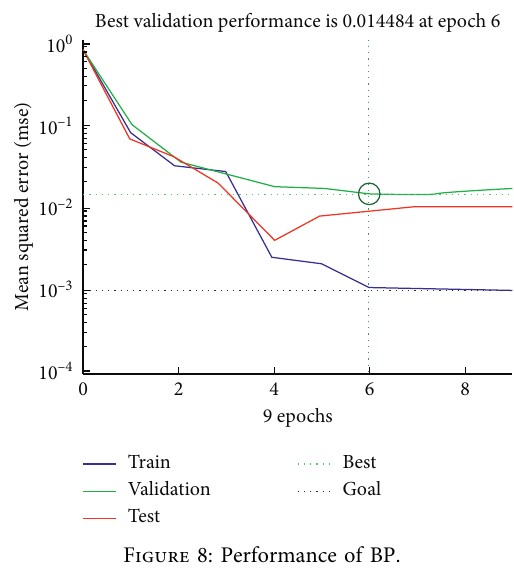
Figure 8: Performance of BP.